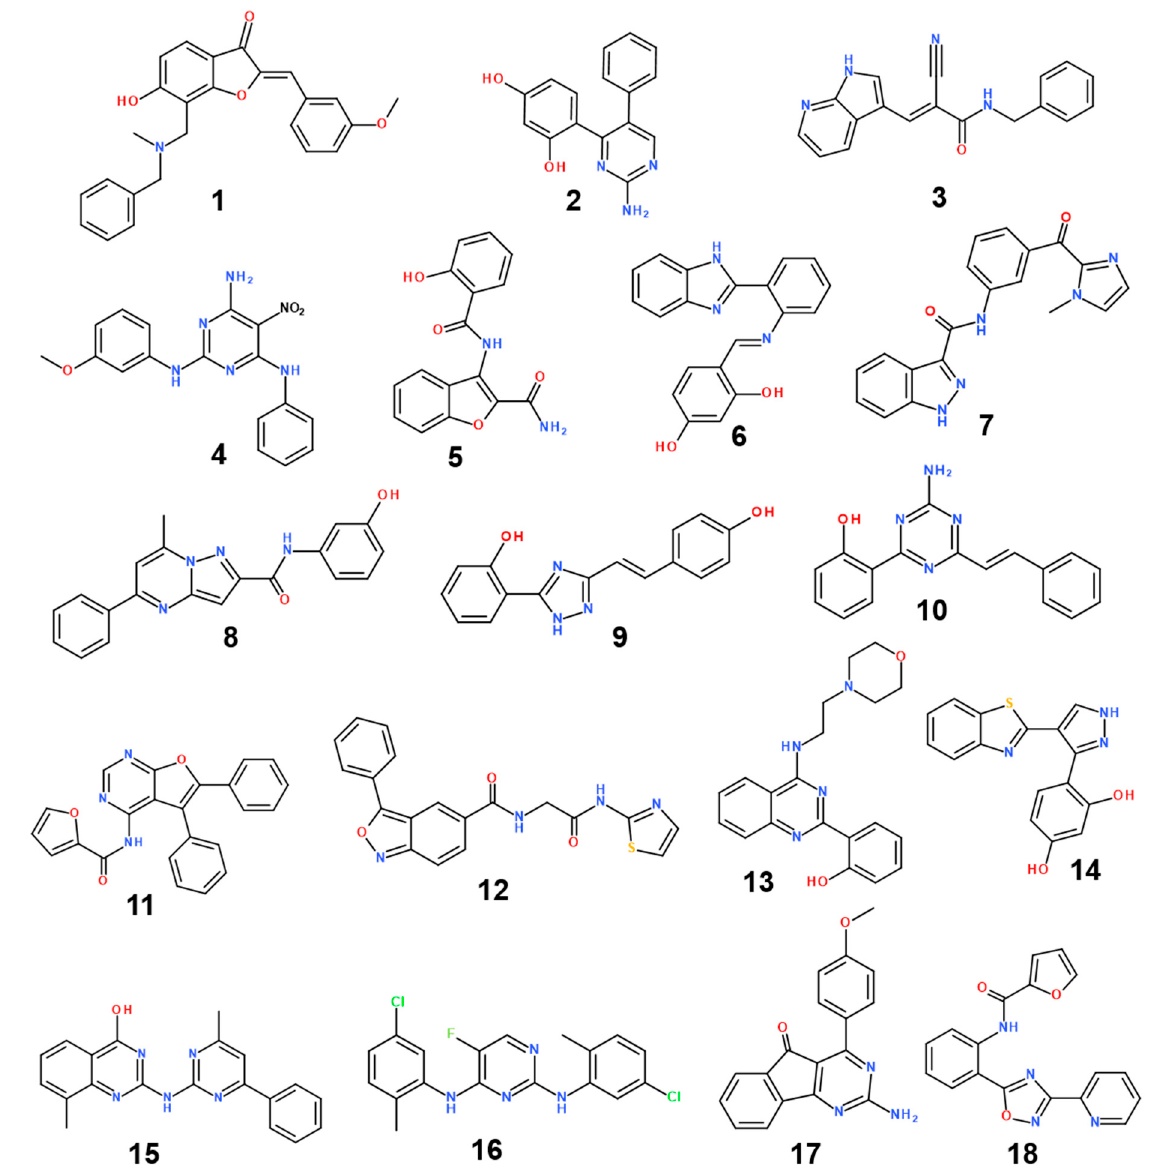
Figure 4. Chemical structures of 18 new inhibitors of the G2019S mutant of LRRK2. It is also worth noting that the inhibitory activities of Inhibitors 1 – 6 against the wild type of LRRK2 are comparable to those against the G2019S mutant. This can be attributed to the low MWs of the inhibitors, which makes it possible for the inhibitors to be bound to the two target proteins in a similar fashion. In this regard, all these inhibitors are supposed to reside in close proximity to the hinge region because the formation of at least one hydrogen bond with Ala1950 served as a criterion to select the virtual hits. Because the amino-acid residue 2019 is located on the activation loop and is distant from the hinge region, the mutational status at residue 2019 would have little impact on the binding affinities of Inhibitors 1 – 6 for LRRK2. Hence, more potent and selective G2019S mutant inhibitors than Inhibitors 1 – 6 would be derived by the enlargement of the molecular size in order to facilitate the interactions with the activation